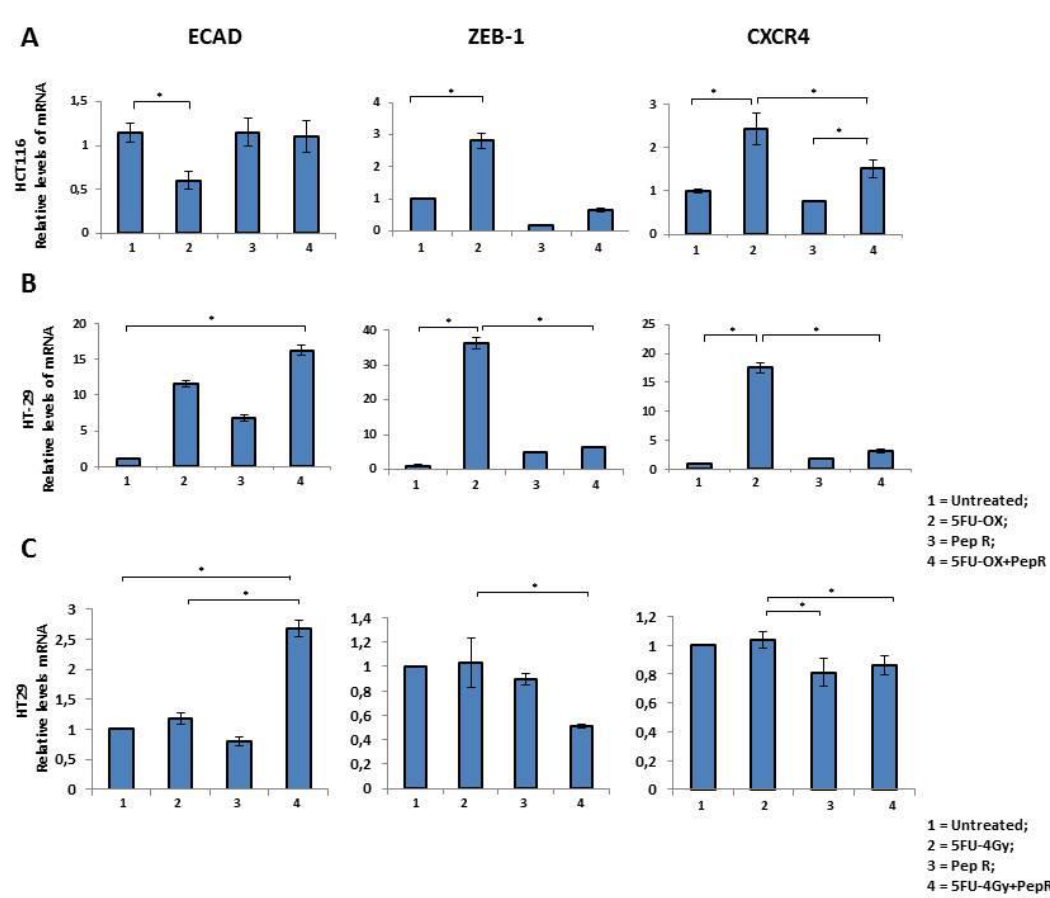
Figure 6. In vitro Peptide R modulates CT-inducing EMT markers. HCT116 ( A ) -2HT9 ( B ). In vitro Peptide R modulated CT/RT-CT EMT-inducing genes in HT29 ( C ). Bar graph illustrating relative mRNA expression levels (qRT-PCR) of indicated genes (means ± SD). The 2 - ΔΔCT method was used as a relative quantification strategy data analysis. Triple determination for each point / gene were performed. p -value < 0.05 (*) (Kruskal-Wallis test followed by Dunn’s multiple comparison). Noteworthy, both CT (Figure 7A) and RT-CT (Figure 7B) selected a stem cell population (CXCR4 + CD133 + ) reduced by Pep R